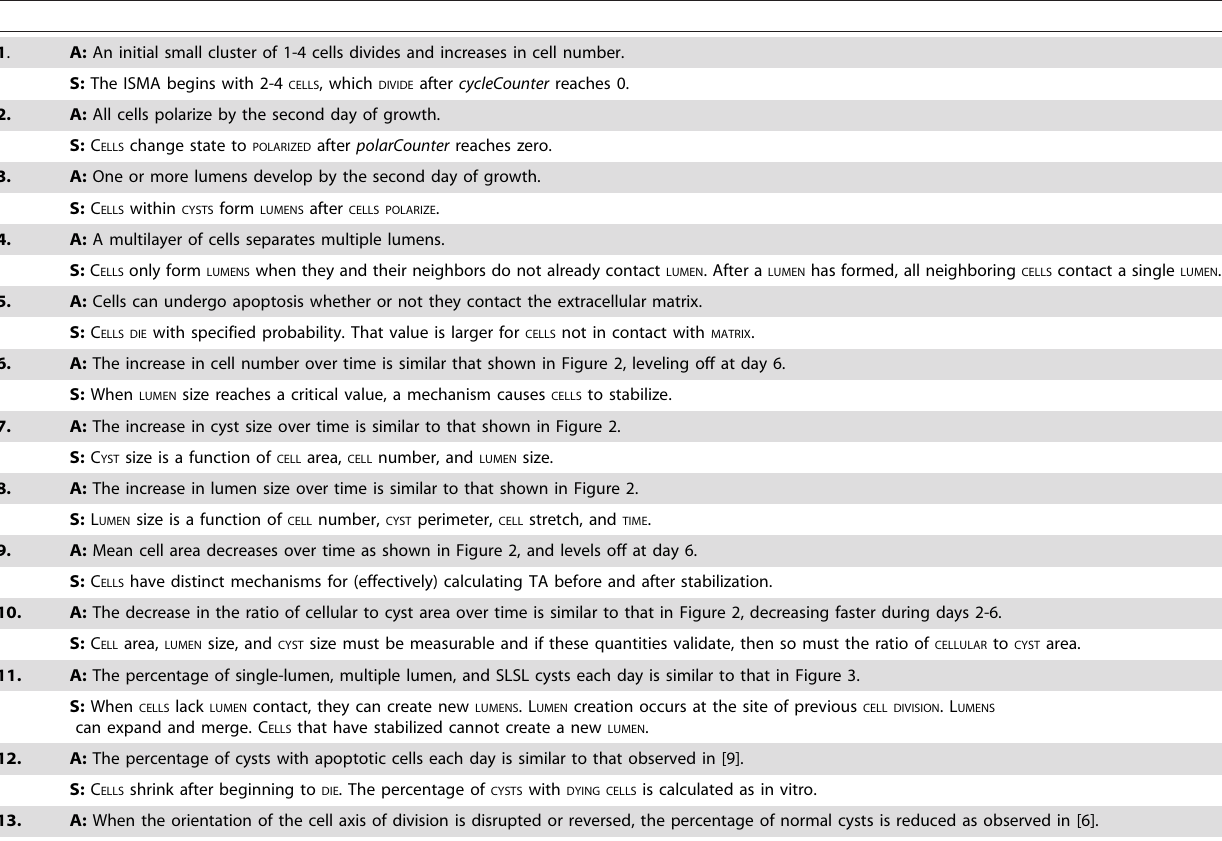
Table 1. Targeted attributes and